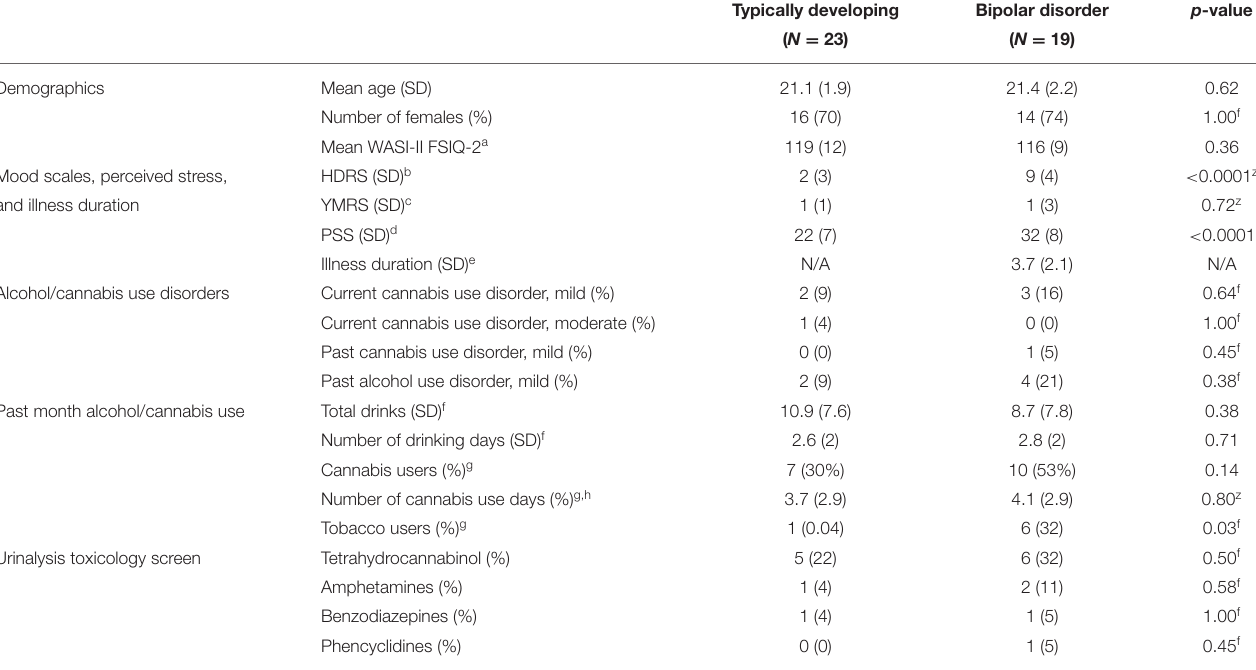
TABLE 1 | Demographic and clinical factors stratified by